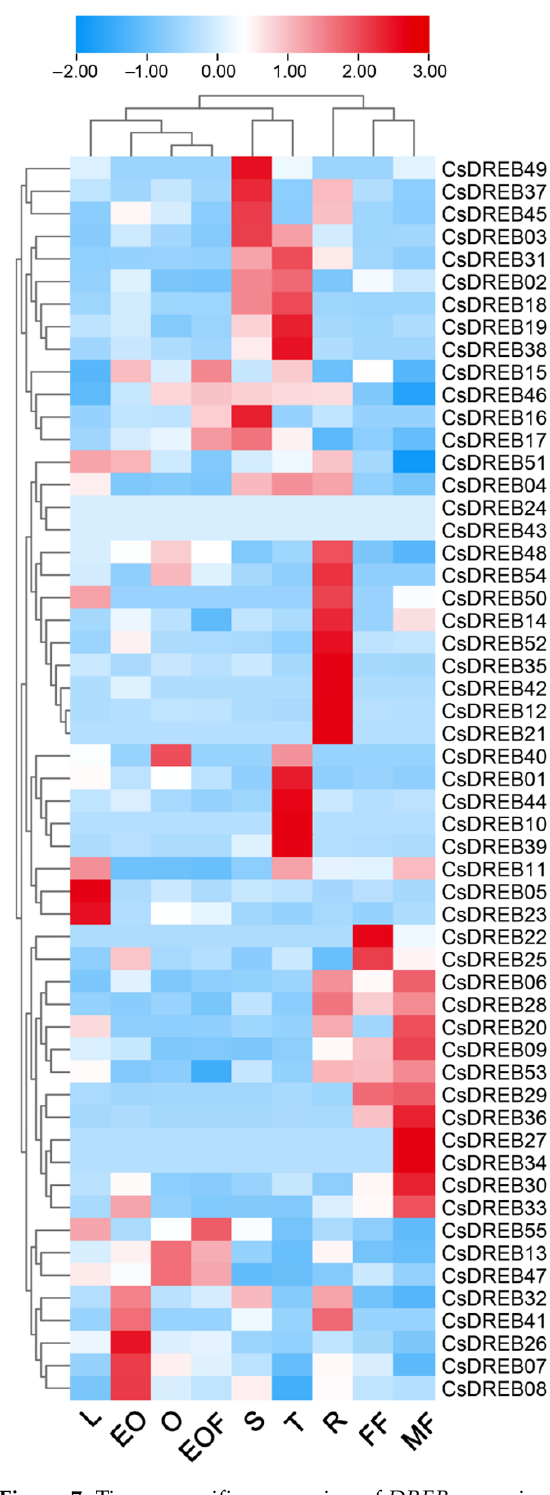
Figure 7. Tissue-specific expression of DREB genes in cucumber: The genome-wide expression of CsDREB genes on a heatmap using FPKM values. A range of − 2.00 to 3.00 was artificially set with the color scale limits according to the normalized values. The color scale shows increasing expression levels from blue to red. S, stem; T, tendril; FF, female flower; EO, expanded unfertilized ovary; L, leaves; O, ovary; EOF, expanded fertilized ovary; MF, male flower; R, root.